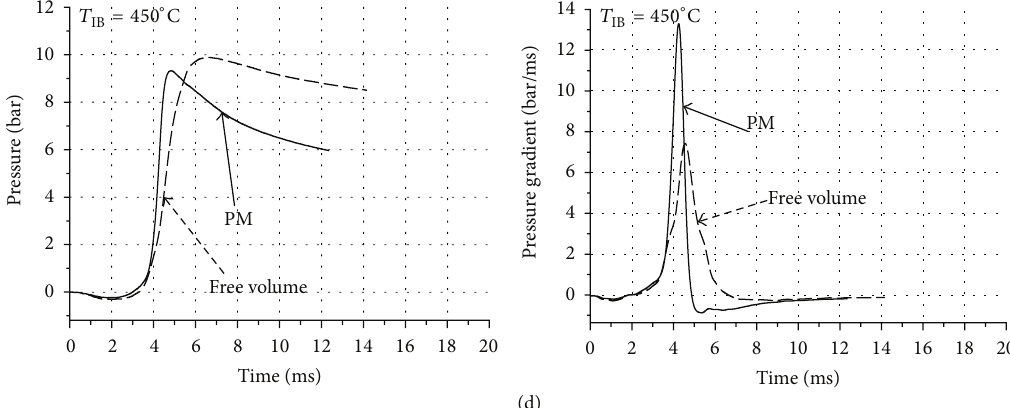
Figure 8: Comparison of pressure histories for heat release in free volume and in an SiC foam porous reactor (8ppi) after fuel injection starts = 18bar. The amount of injected fuel is 23.7 mg: top—complete pressure at different initial temperatures and at constant initial pressure 𝑝 IB history; (a) to (d)—process at individual